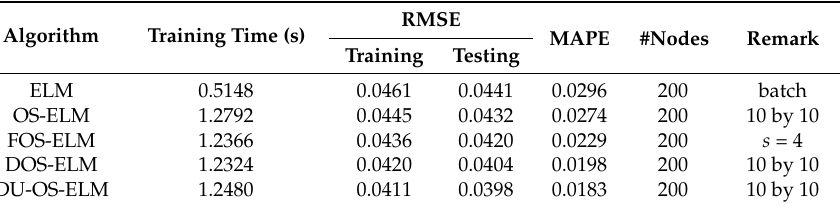
Table A1. Comparison results of different approaches.